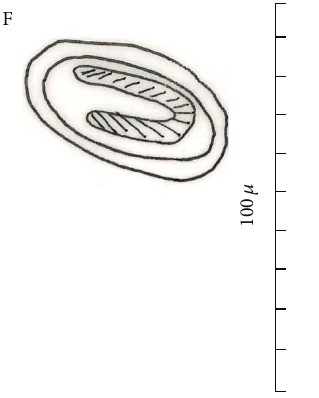
Figure 4: Camera lucida of embryonated